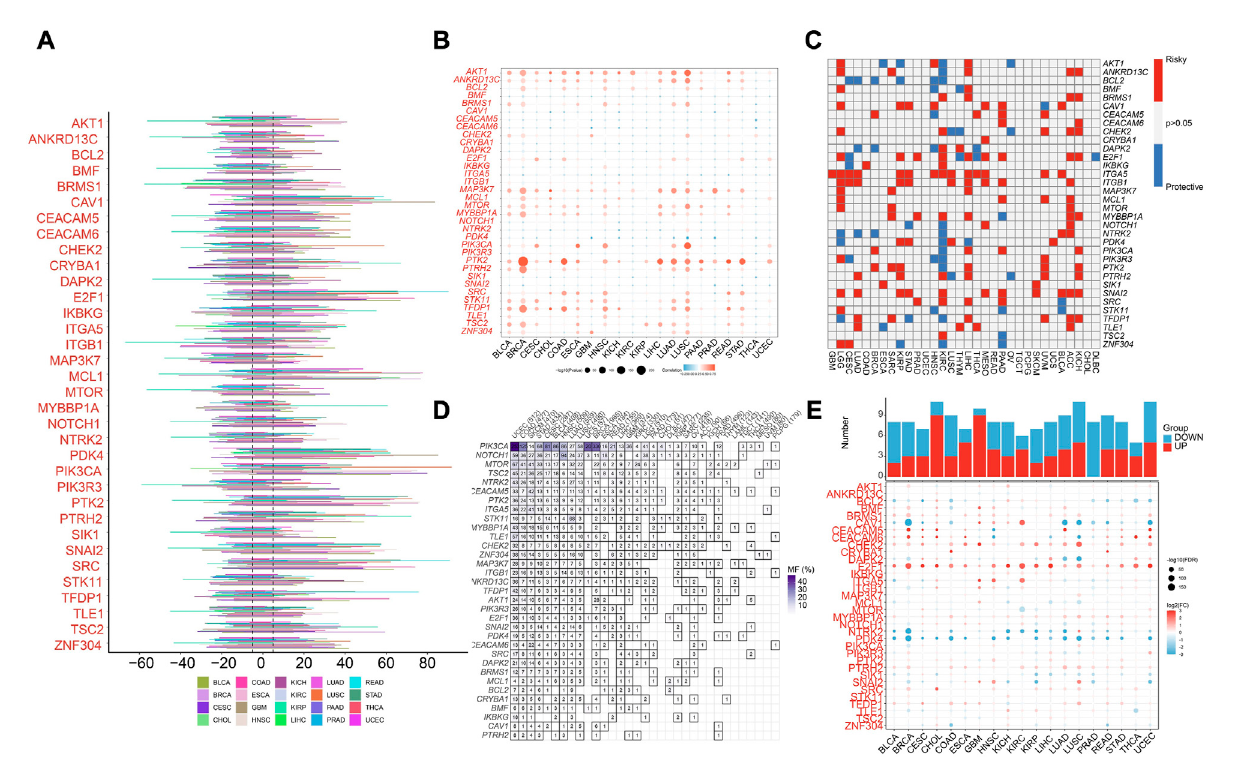
FIGURE 1 Pan-canceranalysisofAnoikis-relatedgenes(ARGs)inpan-cancerTCGAdata. (A) Theillustrationofsomaticcopynumbervariance(SCNV)ofARGs in different cancer types. The percentage of ampli fi cation and deletion was annotated. (B) The correlation of SCNV and expression of ARGs within differentcancertypes. (C) TheprognosticeffectsoftheexpressionofARGsacrossdifferentcancertypes.Redindicatestheriskfactor,andblueindicated theprotectivefactor. (D) ThemutationfrequencyofARGsindifferentcancertypes. (E) TheexpressionpatternsofARGs between tumorand normal samples in different cancer types. The upper histograms illustrate the number of signi fi cantly differentially upregulated (red) and downregulated (blue)